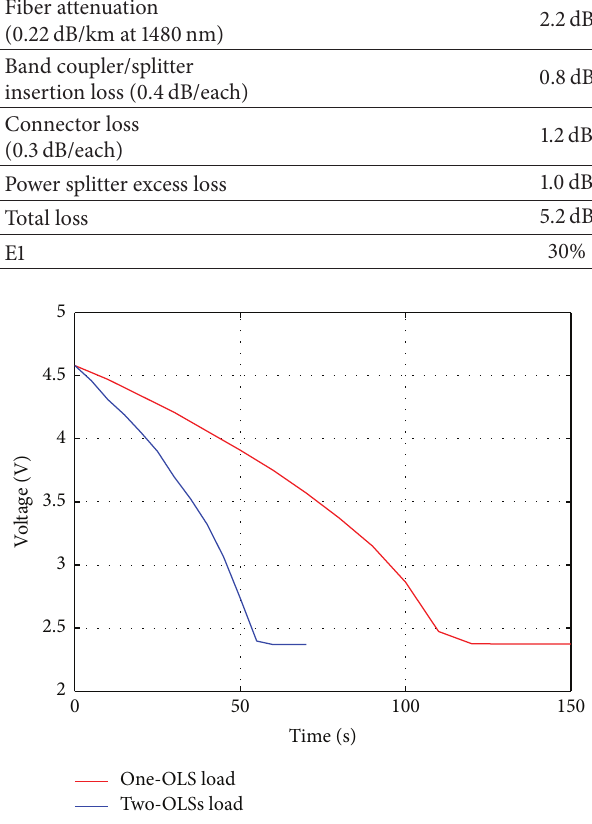
Figure 5: Discharging curves of a 0.1F, 5V SC with one-OLS and two-OLS